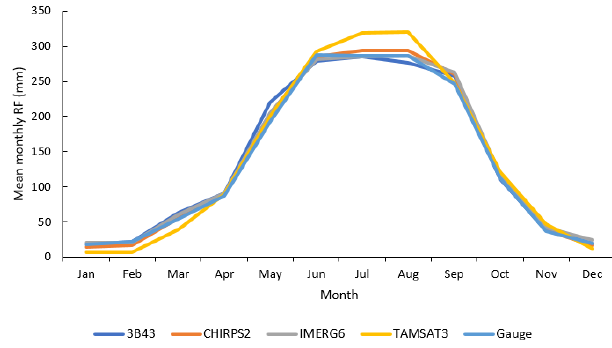
Figure 9. Mean monthly rainfall (2001 to